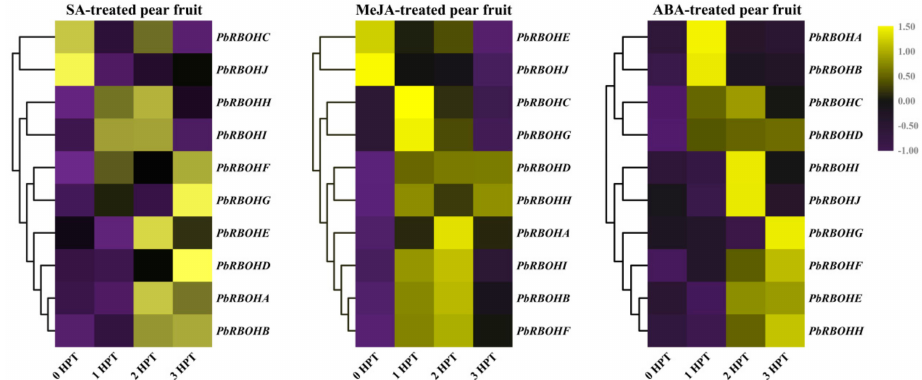
Figure 7. Heatmap representation of PbRBOH s expression in response to salicylic acid (SA), methyl jasmonate (MeJA) and abscisic acid (ABA) treatments. The gene expression data of PbRBOH s at 0 h post-treatment (HPT), 1 HPT, 2 HPT and 3 HPT were obtained through reverse transcription-quantitative real-time polymerase chain reaction (qRT-PCR). The expression data of each gene at 0 HPT was used as a control sample to show the relative expression level. Purple and yellow boxes indicate lower or higher transcript levels, respectively. Each qRT-PCR analysis was performed in